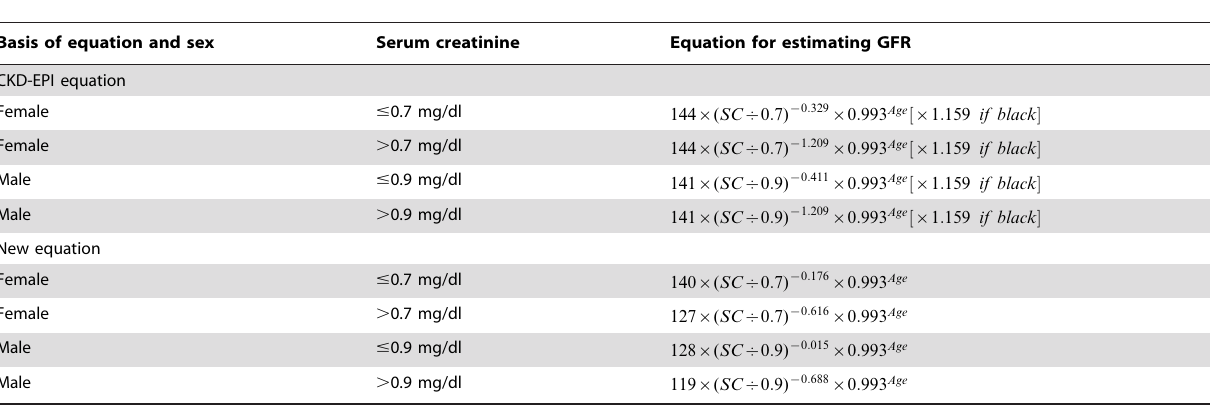
Table 2. CKD-EPI equation and the new equation.